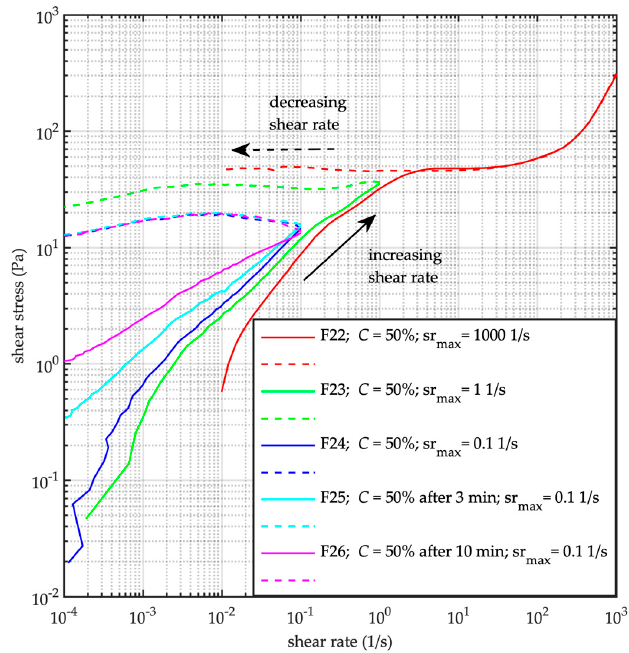
Figure 11. Sediment concentration C = 50%. Flow curves at low shear rate after different resting times (F23, F24, F25 and F26) compared to the reference flow curve test (F22). Runs F22, F23, F24, F25 and F26 (from the top to the bottom of the legend). sr max indicates the maximum shear rate during the test; each test lasts 60 s). ⎯ increasing shear ramp; - - decreasing shear ramp.